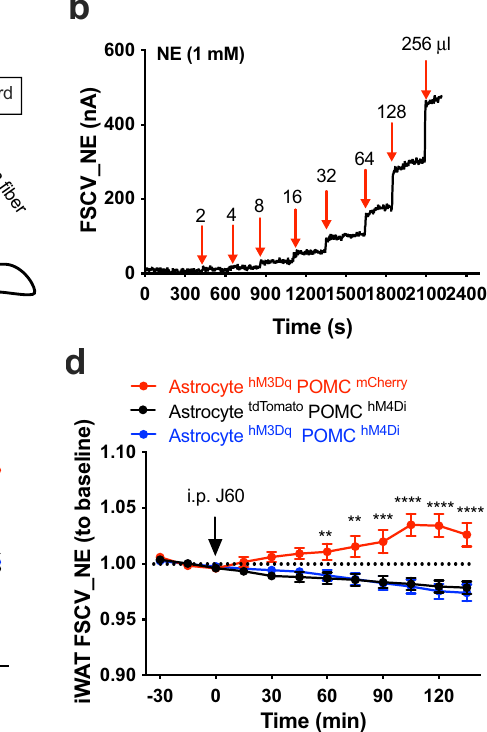
Fig.8|InhibitionofPOMCneuronsdiminishesastrocyticelevationofiWATNE contents. a Schematicillustrationof targeting a vectorcarrying GfaABC 1 D-hM3Dq and a second vector carrying Cre-dependent hM4Di to the ARH and of implanting anFSCV carbon fi ber electrode in iWATin POMC-Cre mice. b NE probe calibration curve usingincreasedvolumes of NE(1mM) following the detailed instructions for the probes. c Representative traces of real-time recording of the FSCV signals of iWAT in astrocyte hM3Dq POMC neuron mCherry ( n =5), astrocyte tdTomato